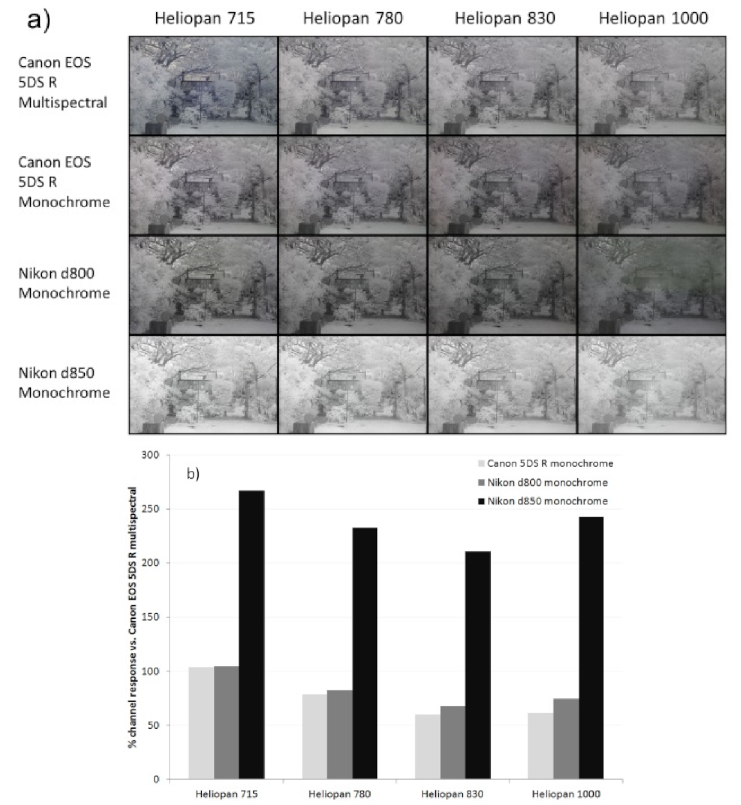
Figure 6. IR images taken with test cameras, using different IR filters: ( a ) direct image comparison; ( b ) average channel response of the diffuse reflectance target with the different cameras compared with the Canon EOS 5DS R multispectral camera for the different IR